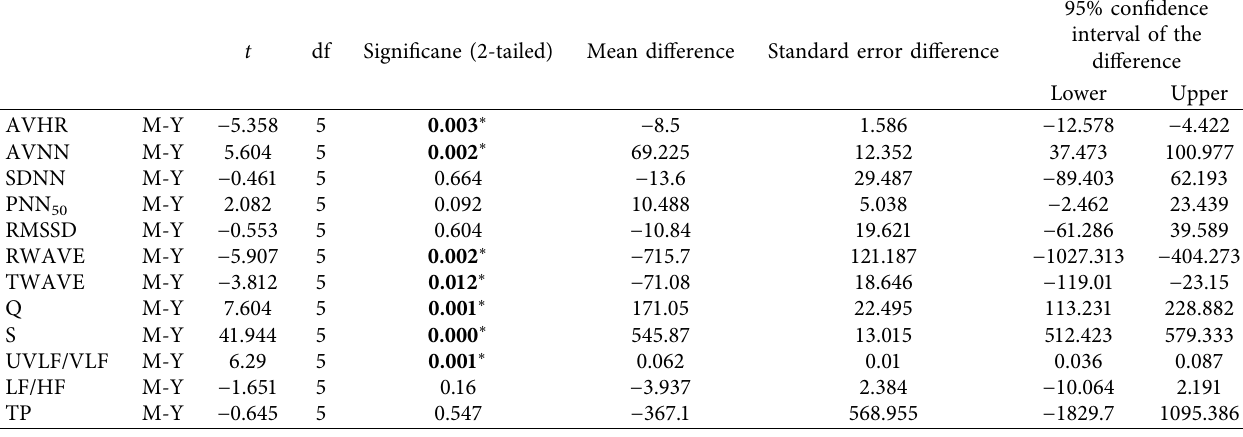
Table 7: Independent t -test results of ECG characteristics for young and middle-aged drivers in